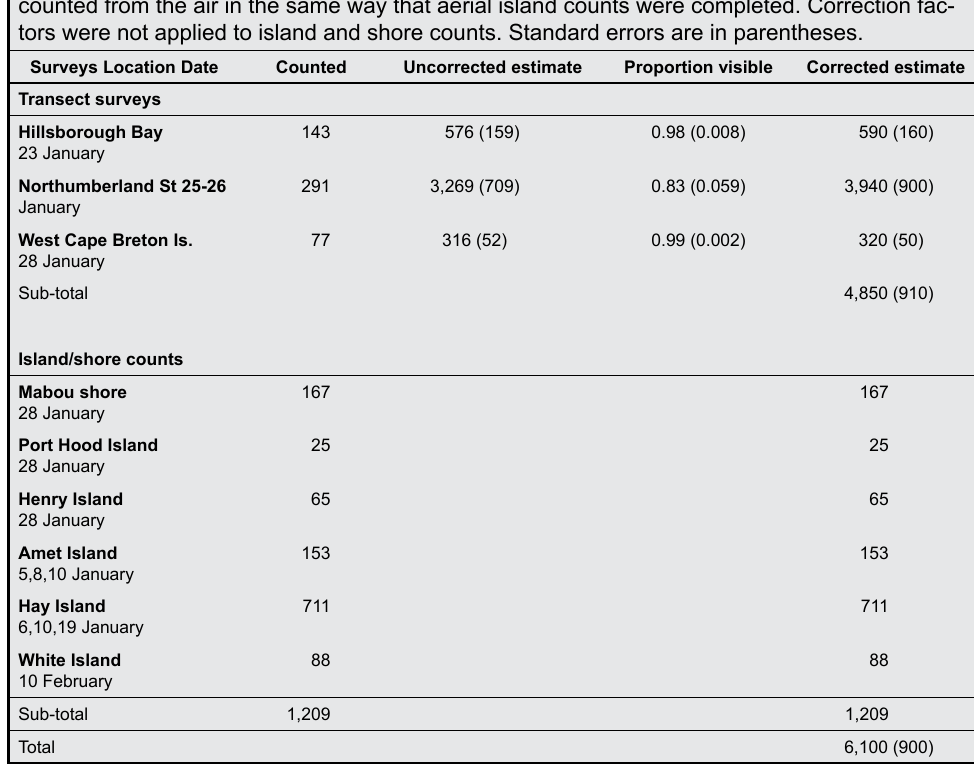
Grey seals in the North Atlantic and the Baltic